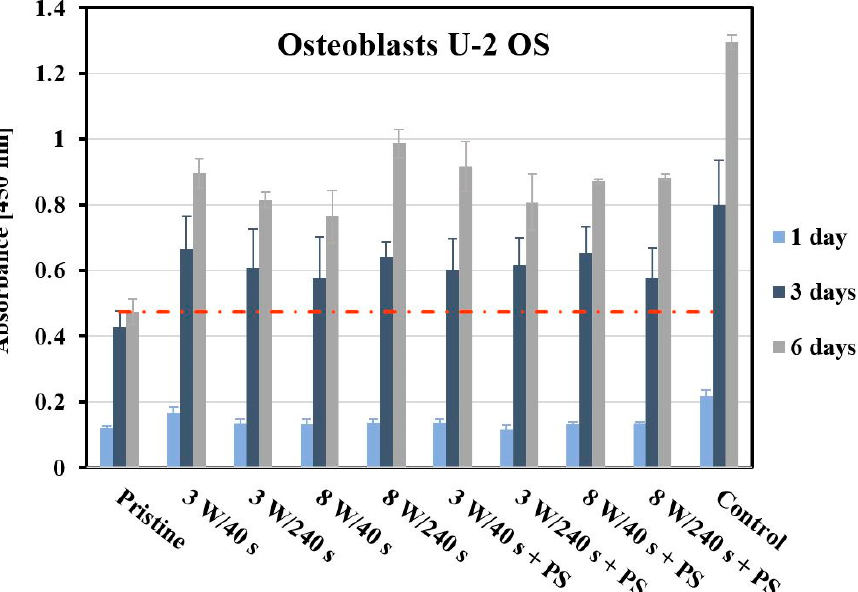
Figure 8. Metabolic activity of human osteoblasts (U-2 OS) growing on the studied FEP substrates. Cell metabolic activity was determined spectrophotometrically using WST-1 assay at 450 nm at 1, 3, and 6 days post-seeding. As a control, glass coverslips were used. The error bars represent the standard error of the mean of three replicates.